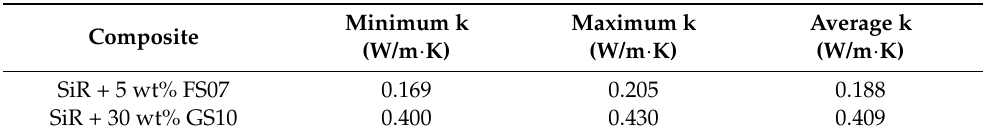
Table 2. Thermal conductivity measurements (k) of the composites based on the 15 acquired mea- surements of each composite with a precision of ± 1%.